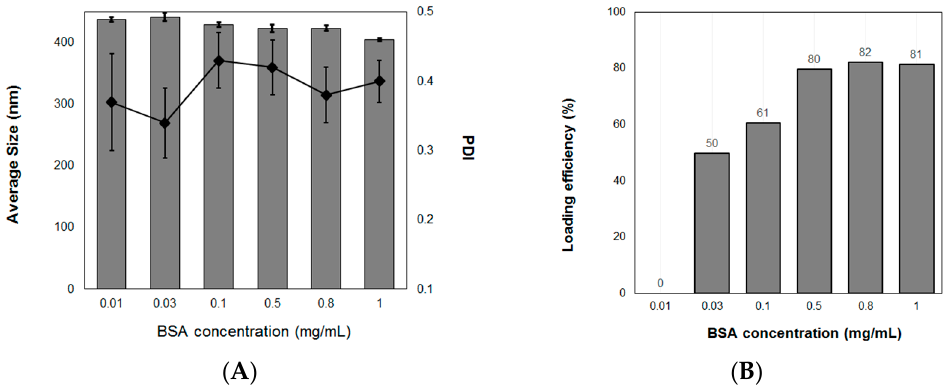
Figure 11. Effect of protein concentration on ( A ) the particle size and PDI and ( B ) loading efficiency of AL-CS nanoemulsion prepared with sacha inchi oil. BSA, bovine serum albumin.